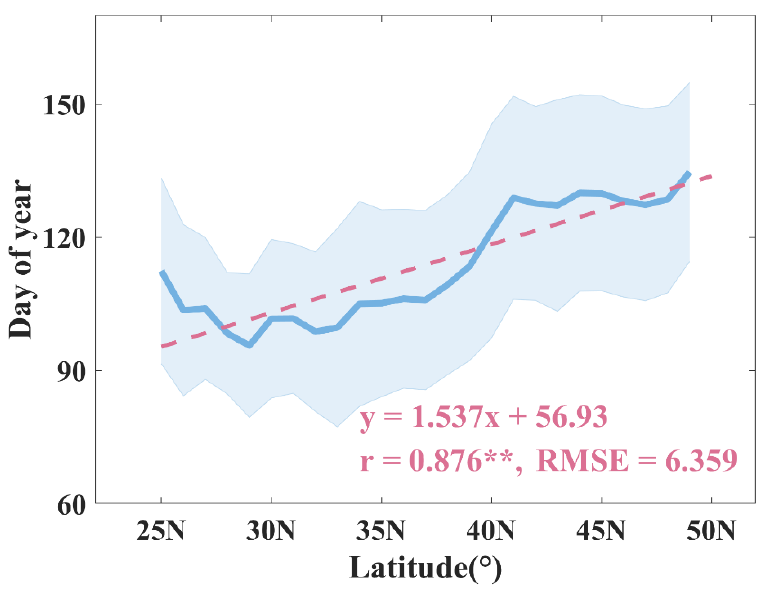
Figure 5. Trend of mean SOS (2001–2021) in the latitudinal direction. The light blue bar represents the standard deviation. ** denotes p < 0.01.